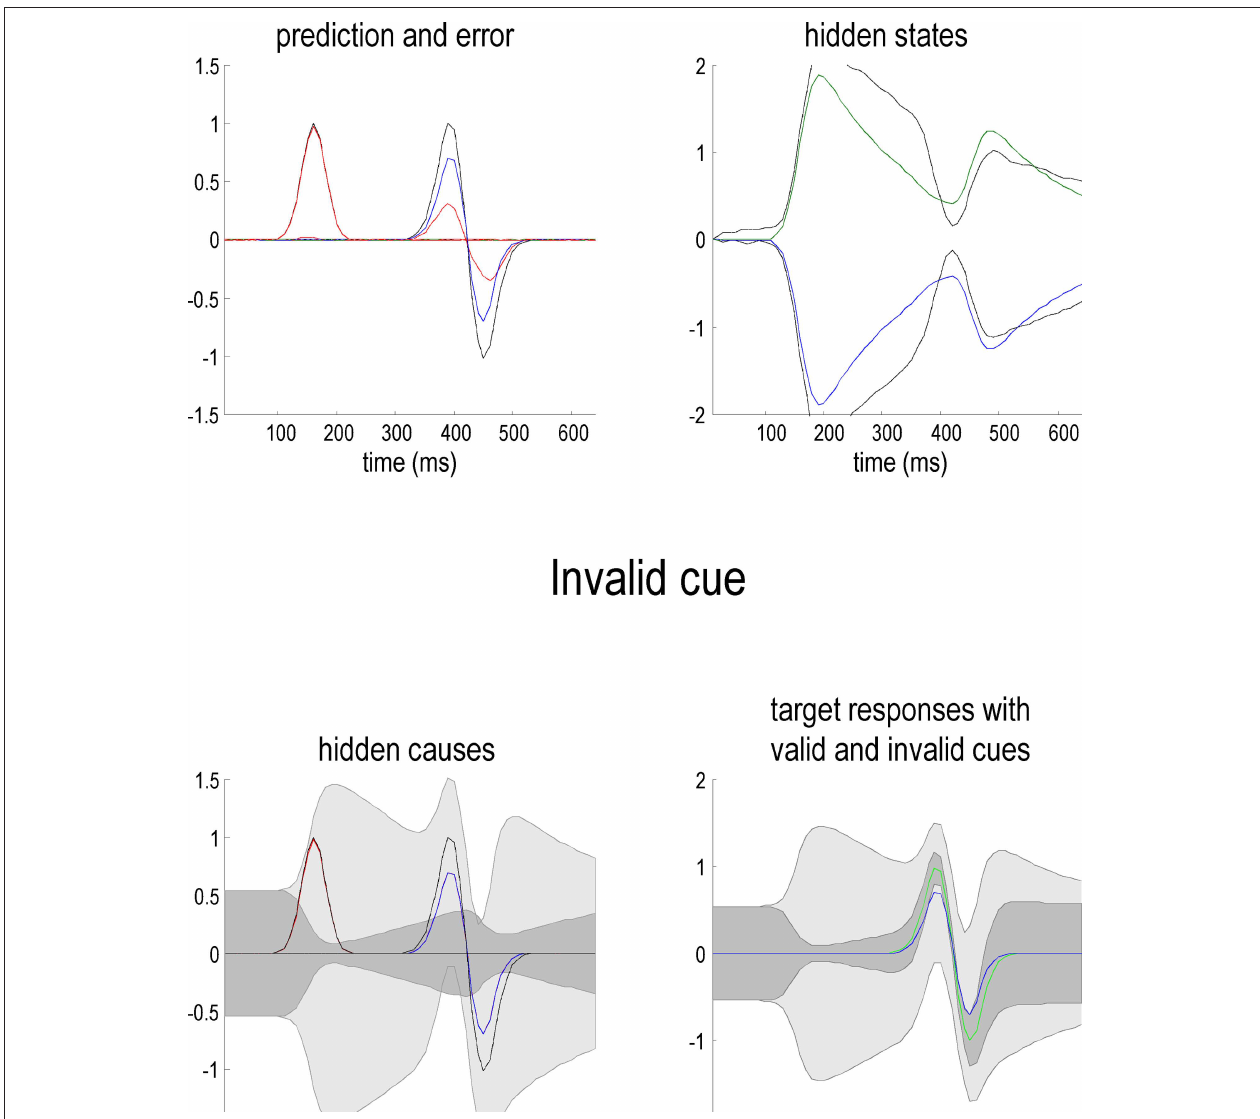
target (lower left panel) are now much larger than in the previous figure. This is shown in the lower right panel, where one can compare the conditional estimates of the valid (green; see Figure 2 ) and the invalid (blue) hidden cause, with their respective conditional confidences (gray). Note that these responses were elicited using exactly the same stimulus